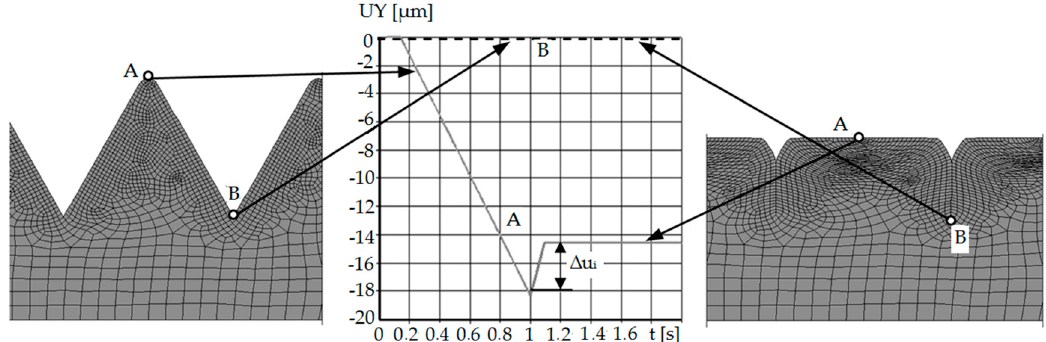
Figure 14. Diagram of displacement along the Y axis of selected nodes of asperity with a vertical angle in the process of crushing with a flat punch: A—top of asperity, B—bottom between asperities.